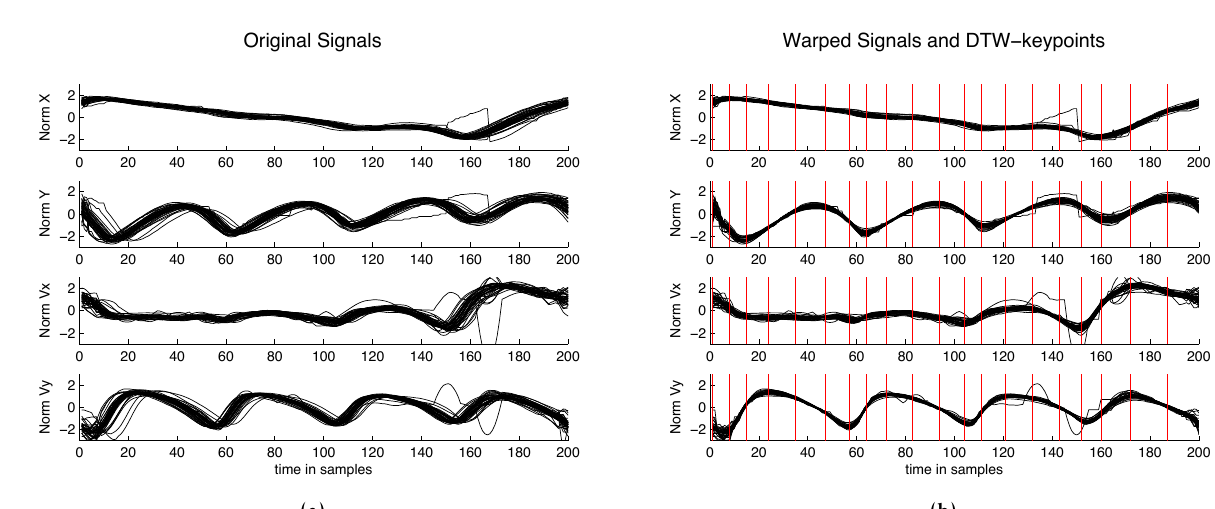
Figure 7. The original signals are shown in the left figure. The warped signals together with the set of time markers (red lines) are shown in the right figure (for conducting model 3).